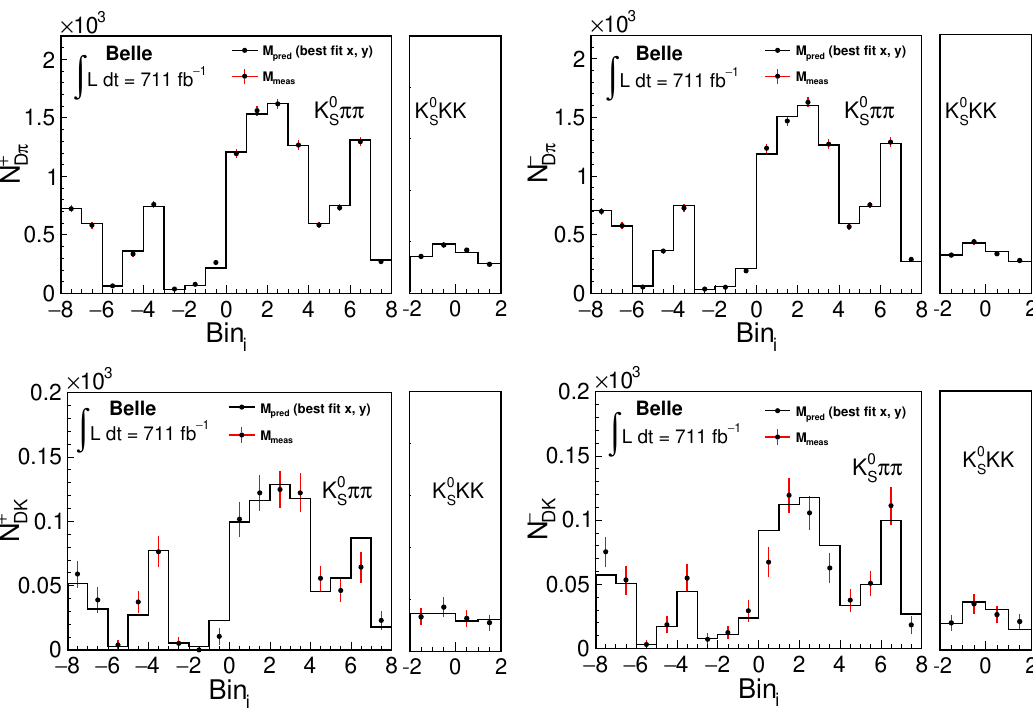
Figure 6 . Yields in bins for B + → Dπ + (top left), B − → Dπ − (top right), B + → DK + (bottom left) and B − → DK − (bottom right) decays in the Belle data set. The data points with error bars are the measured yields with their statistical uncertainty and the histogram is the expected yield from the best fit ( x ) parameter ± , y ±